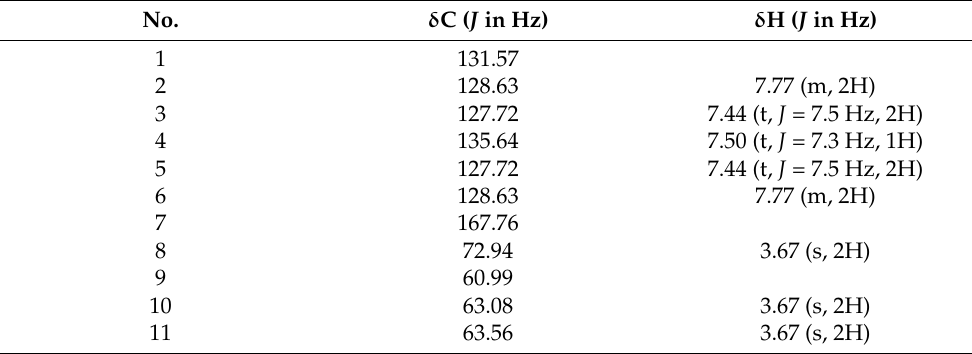
Table 3. 13 C NMR and 1 H NMR data for